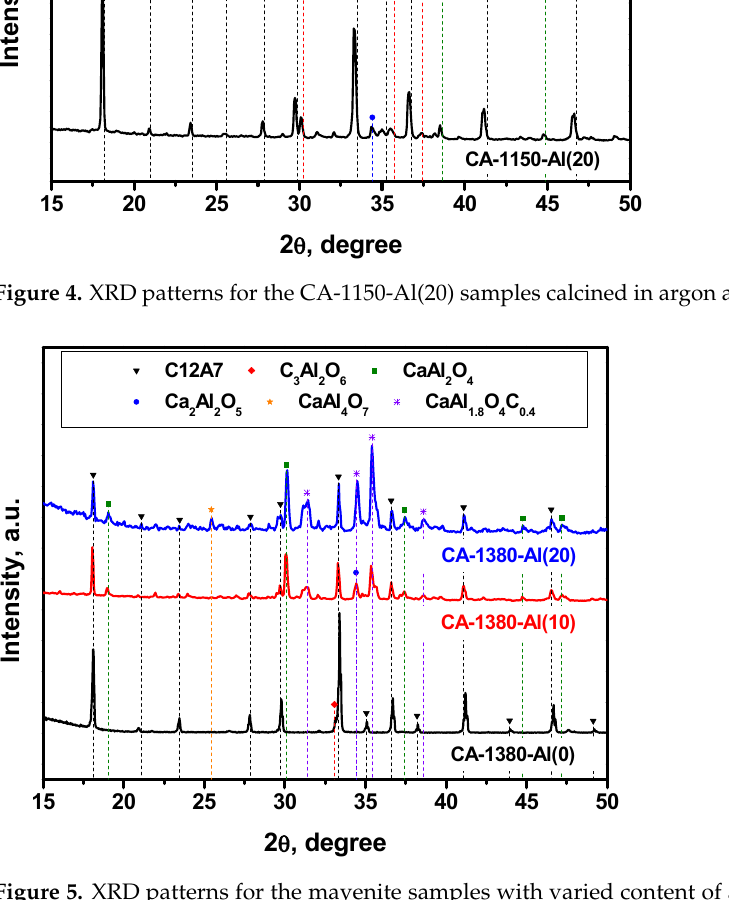
Figure 4. XRD patterns for the CA-1150-Al(20) samples calcined in argon and air at 1150 °C.